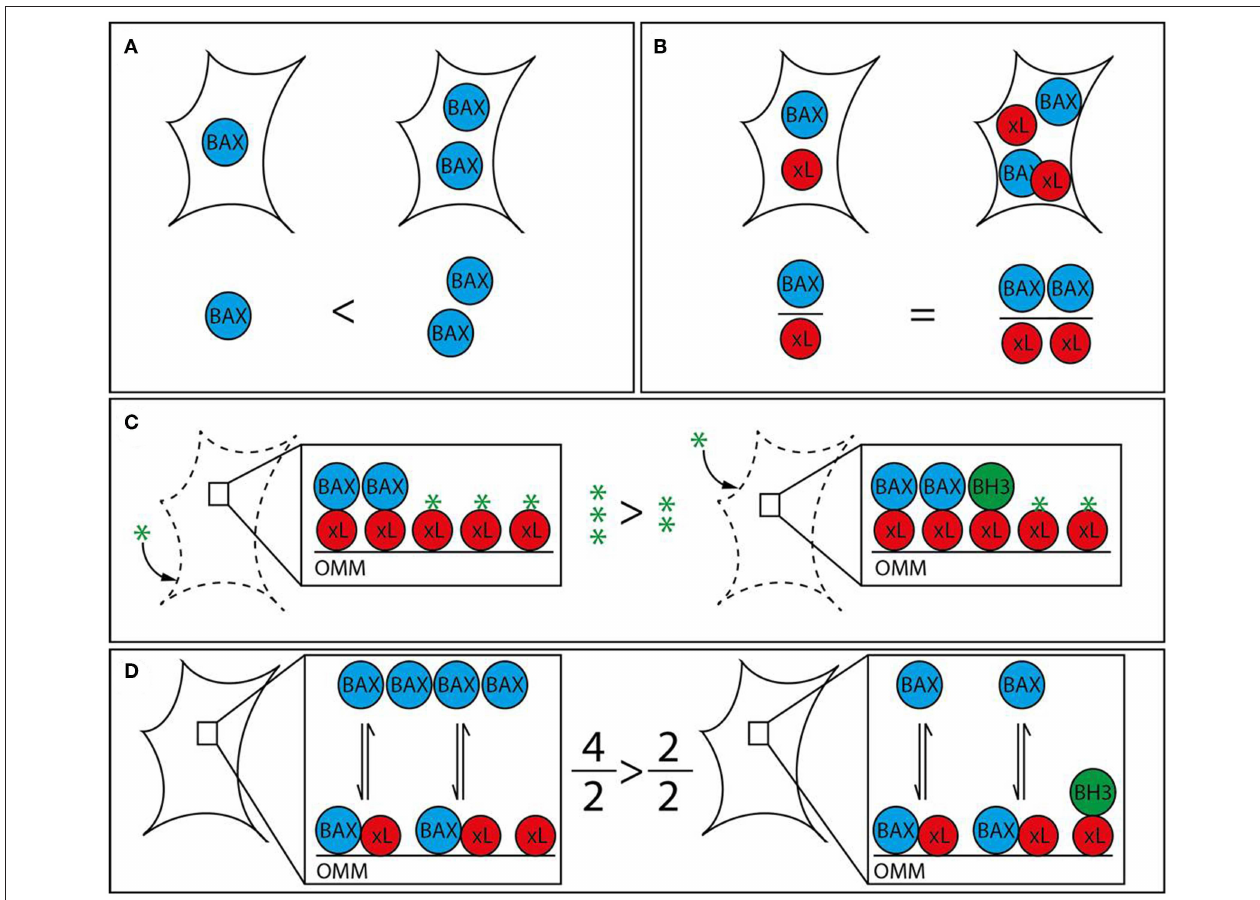
FIGURE 1 | Strategies to analyze apoptotic predisposition based on BCL-2 proteins. (A) BAX level. The right cell contains more BAX (blue) than the left and is therefore considered to have a higher apoptosis predisposition. Other relevant factors are not measured. (B) BAX vs. BCL-xL level. The ratio between BAX and a single pro-survival BCL-2 protein (BCL-xL, red) is similar in both cells. Therefore, both cells would be judged to have the same tendency to initiate apoptosis. The redundancy of the BCL-2 family would require this analysis to be expanded to all BCL-2 proteins in order to be insightful. (C) BH3 profiling. Permeabilized and cultured cells are incubated with BH3 peptides (green star) in order to titrate the amount of free BH3 binding sites on the outer mitochondrial membrane (OMM). BH3-only proteins (green) associated with the OMM following prior cell stress reduce the amount of free BH3 binding sites and thus increase the sensitivity toward BH3 mimetics. The increased capacity of the left cell would translate into a reduced sensitivity toward BH3 mimetics. (D) Relative BAX localization. Determination of the cytosolic and mitochondrial BAX pools in intact cells describes the position of the BAX localization equilibrium and thus the cellular predisposition to apoptosis. While single contributing factors cannot be dissected, all contributing factors, e.g., BCL-2 protein interactions with BH3 motifs and other segments, interacting proteins outside the BCL-2 family, are included. BH3-only proteins reduce the shuttling rate and thus the cytosolic BAX pool. The larger cytosolic pool of the left cell shows reduced predisposition to apoptosis. The analysis can be supplemented with measuring the functionally redundant and similarly regulated BAK, which is usually shifted toward the mitochondria but shows a similar range of localizations in human